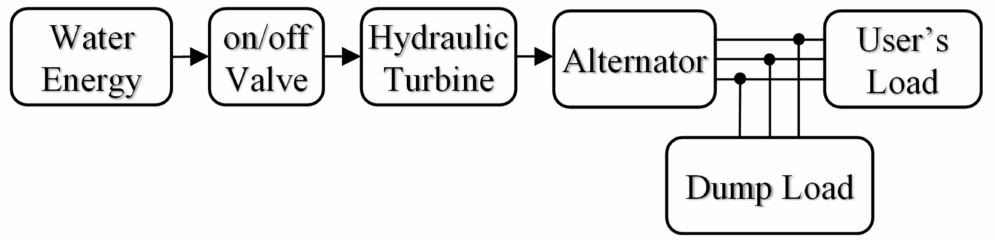
Figure 4. Functional diagram of a micro-hydro power